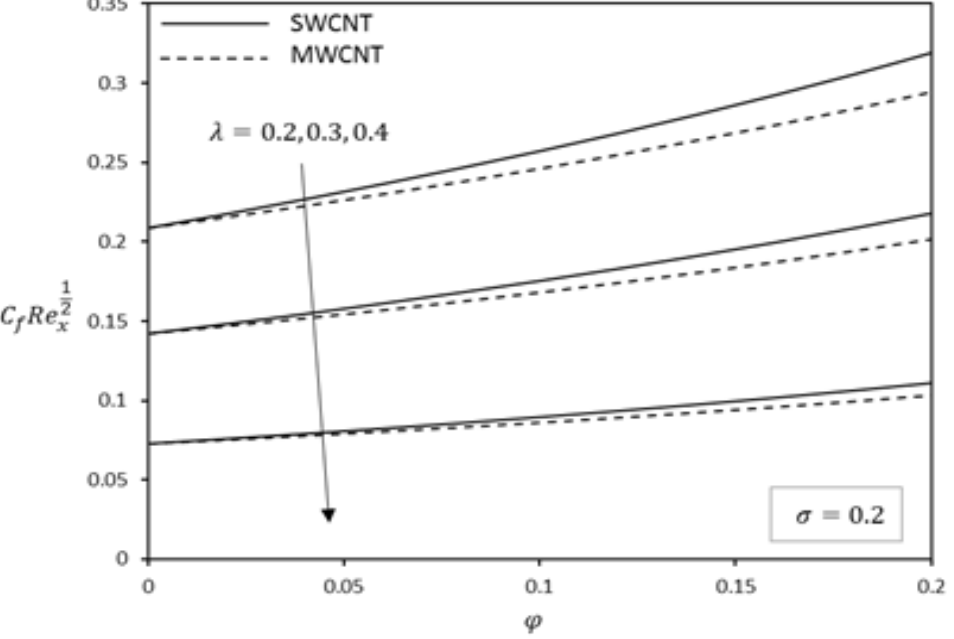
Figure 9. Effect of λ on skin friction for water-based fluid.